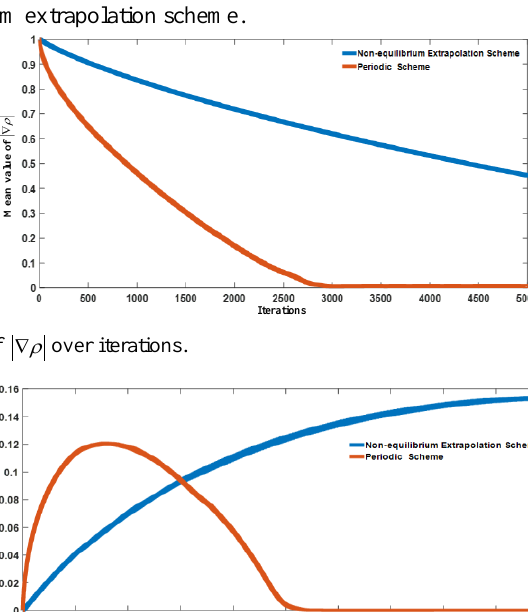
Fig. 5. Variance of  over